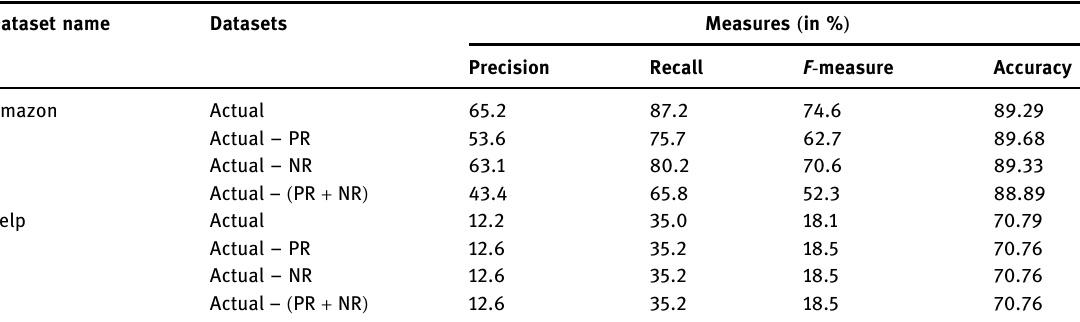
Table 2: Train dataset: